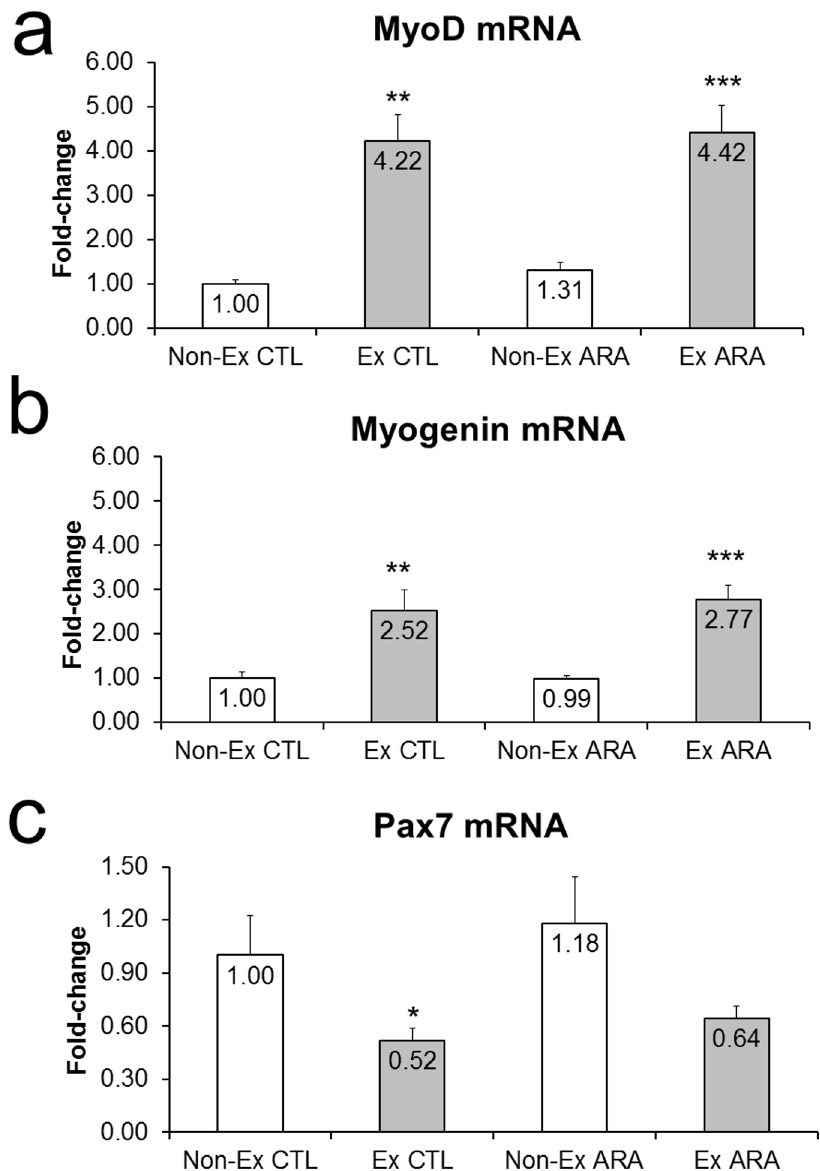
Fig 6. Fold-change values for MyoD mRNA (a), Myogenin mRNA (b), and Pax7 mRNA in non-exercised (open bars) and exercised (closed bars) rodents with (right) and without arachidonic acid